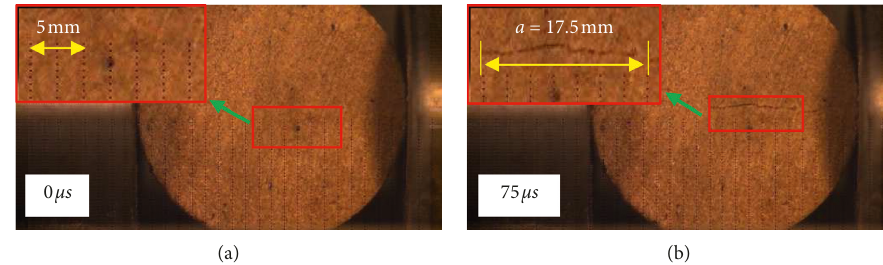
Figure 5: An illustration of crack propagation velocity computation using crack length.